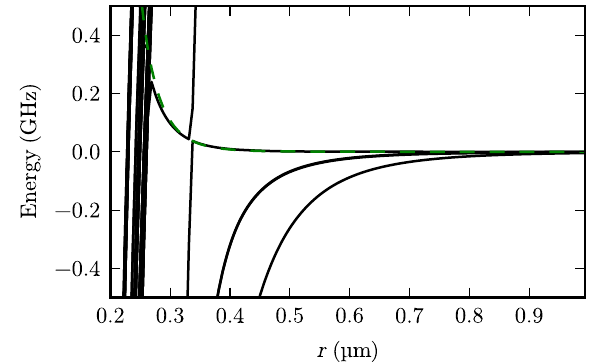
; 25 P 1 = 2 = 2 i states. j